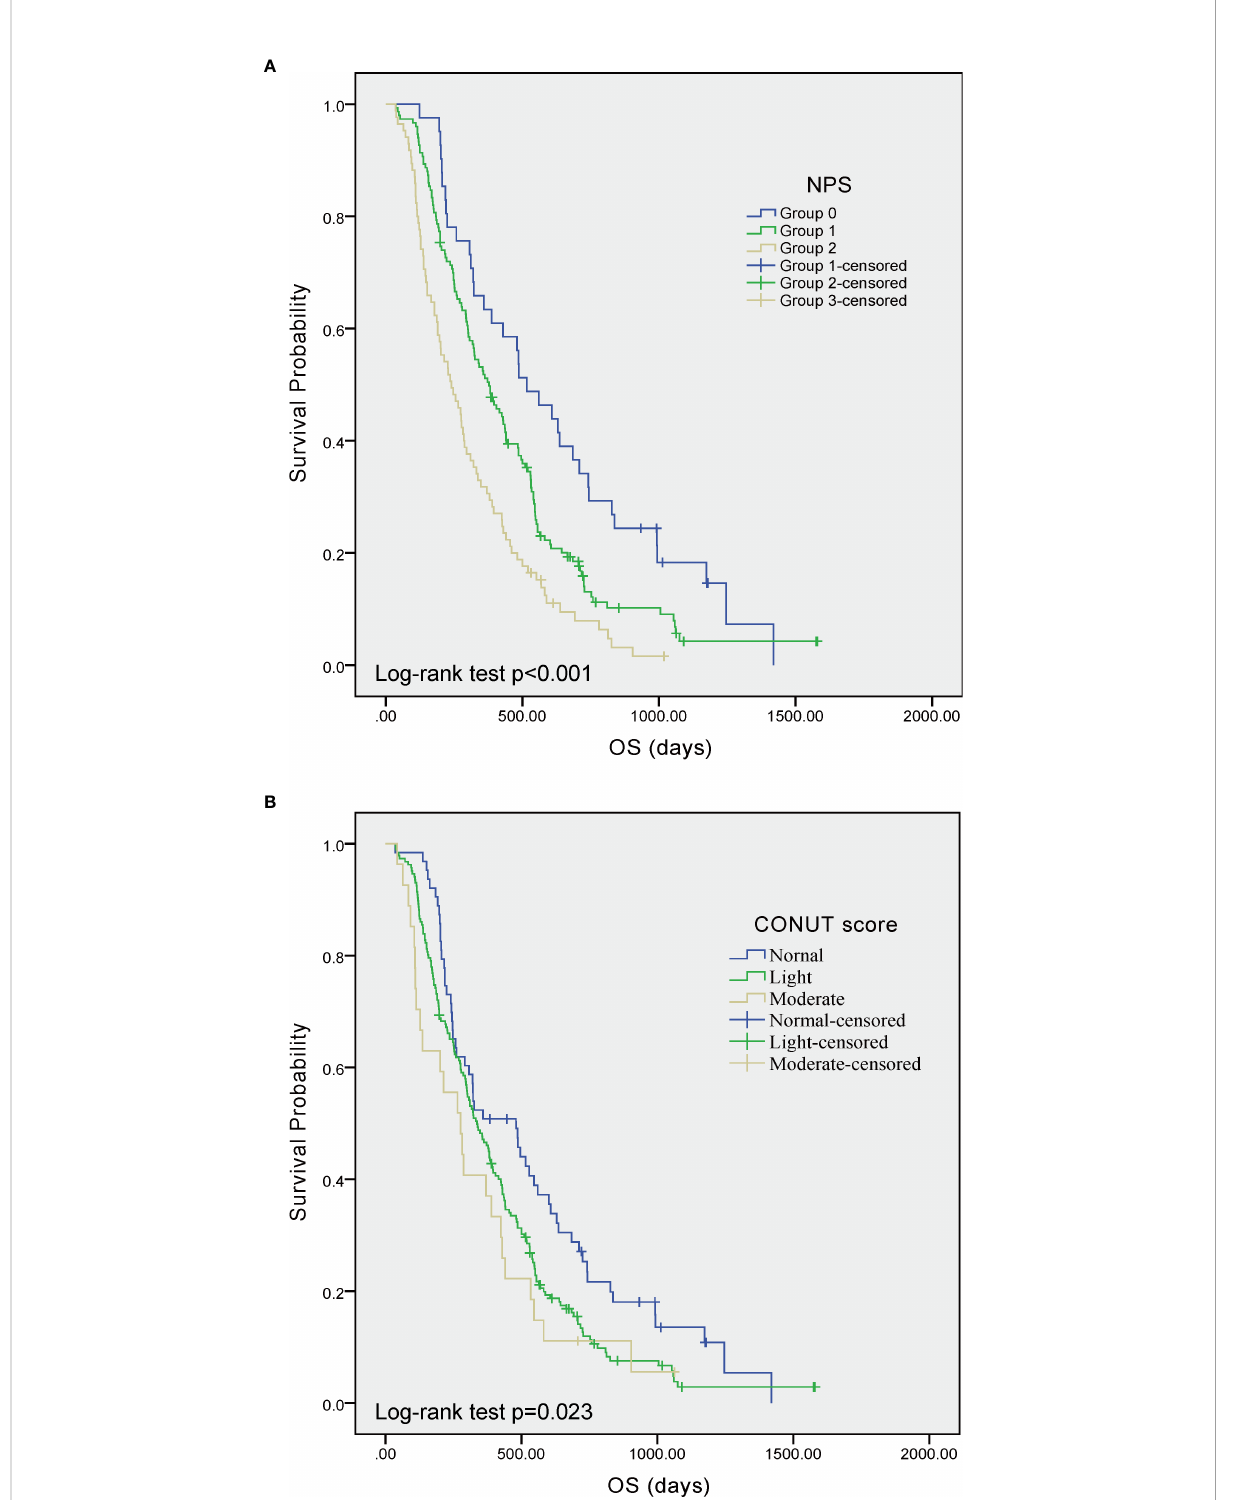
FIGURE 2 Kaplan – Meier curves showing overall survival of GBM patients strati fi ed by value of NPS (A) and CONUT score (B) , respectively. GBM, glioblastoma; NPS, Naples prognostic score; CONUT, Controlling Nutritional Status; OS, overall